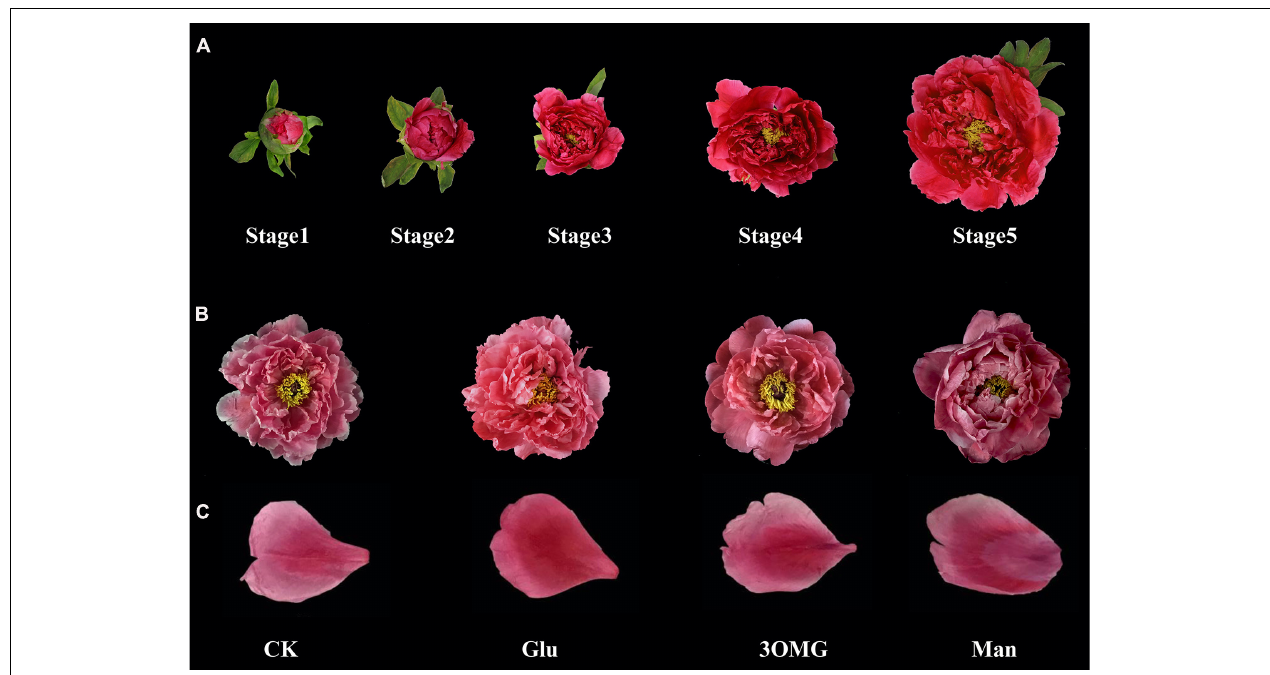
FIGURE 1 | P. suffruticosa ‘Tai Yang’ (A) On-tree flowers of P. suffruticosa ‘Tai Yang’ at five developmental stages. Stage 1, soft bud stage; stage 2, pre-opening stage; stage 3, initial opening stage; stage 4, half opening stage; stage 5, full opening stage. (B) Flowers at stage 5 under four treatments. (C) Petals of flowers under four treatments. There were four treatments including CK, Glu, 3OMG, and Man, respectively. CK was the control group that cut flowers treated with distilled water. Glu, 3OMG, and Man were the cut flowers treated with glucose, 3-O-methylglucose, and mannose at 333 mM, respectively.